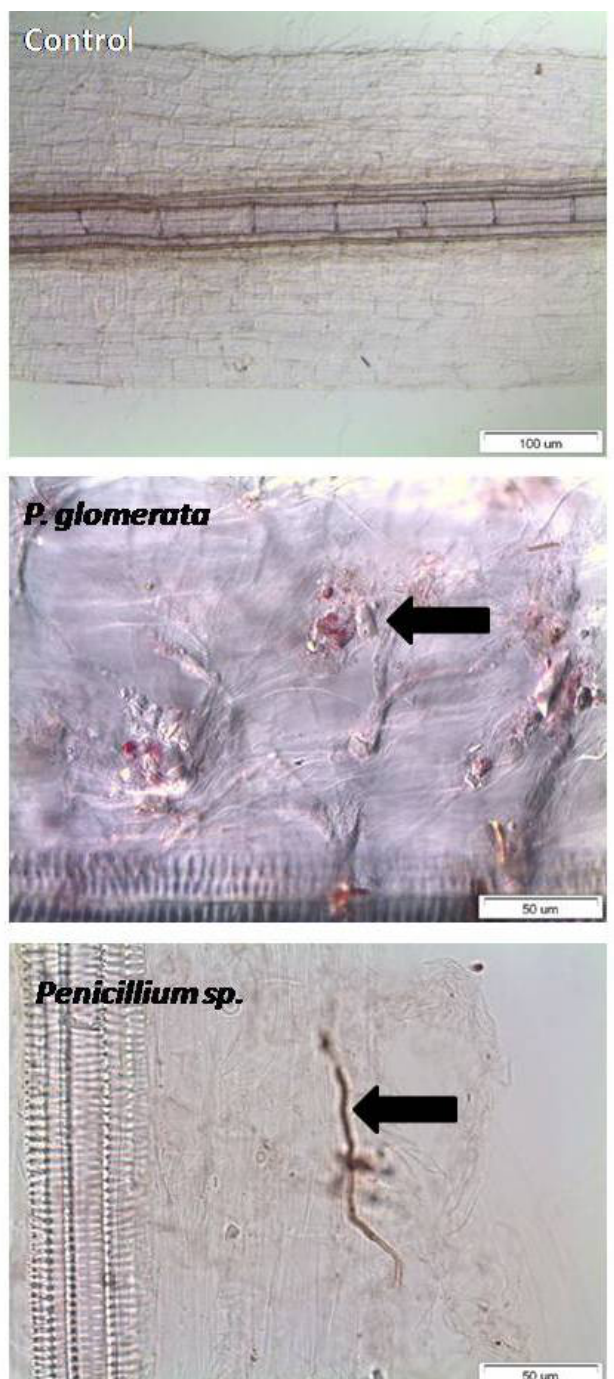
Figure 3. Endophyte associated with the roots of host cucumber plants. The control plant’s roots did not had any fungal colonization. Bar = 100 µm. P. glomerata occupied the pericycle regions of the roots in brownish yeast-like cells. Bar = 50 µm. The Penicillium sp. were found in the cortex region of the root. Bar = 50